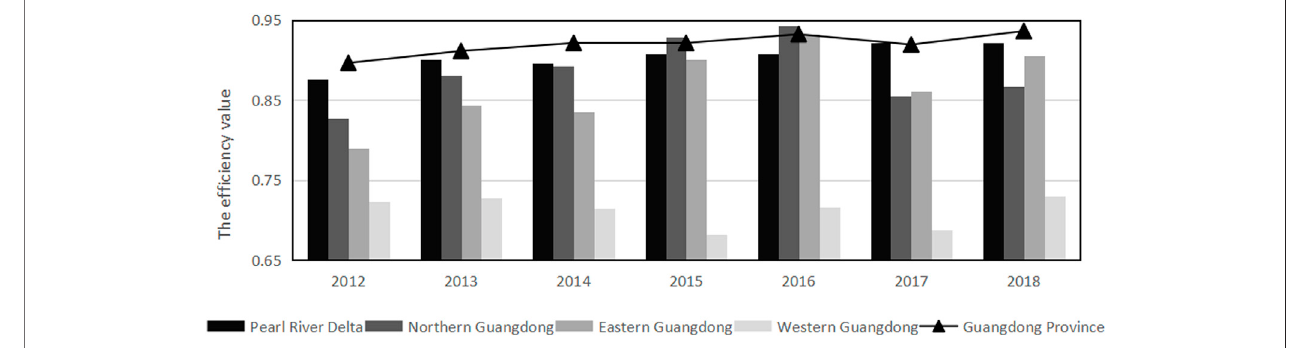
FIGURE 3 | Average WUE in different regions of Guangdong